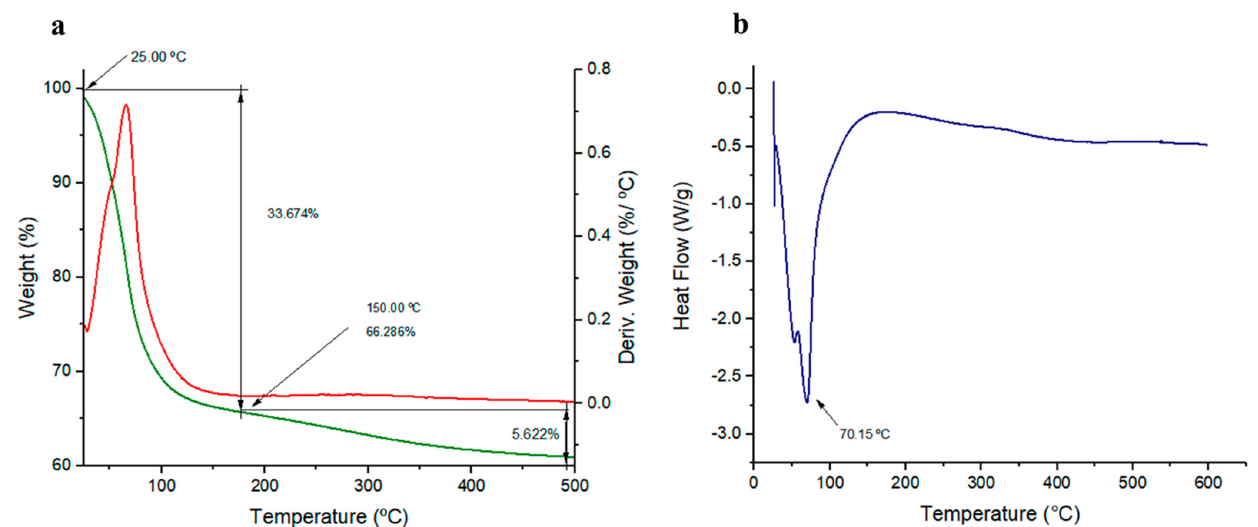
Figure 5. ( a ) Thermogravimetric (TGA) analysis of EPS t . ( b ) Differential scanning calorimetry (DSC) analysis for EPS t .